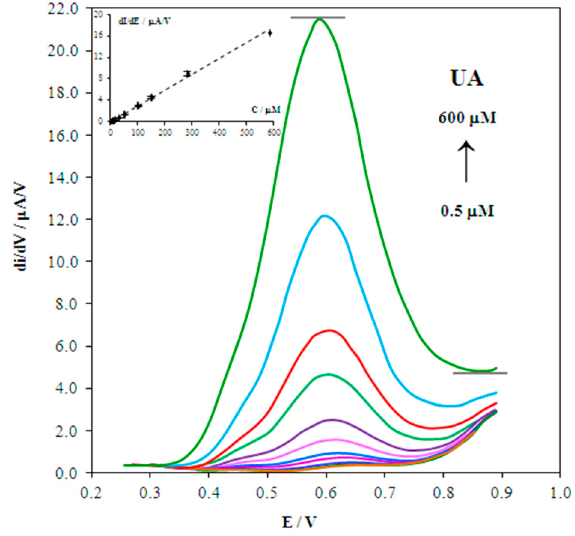
Figure 7. Derivative anodic voltammograms with increasing concentrations of UA (0.5–600 μ M) at the 2.5% Nf/Au(5nm)/CSPE. Inset: corresponding calibration curve d I /d E = f( C ). Background: PBS ( рН 5), ν = 50 mV/s.